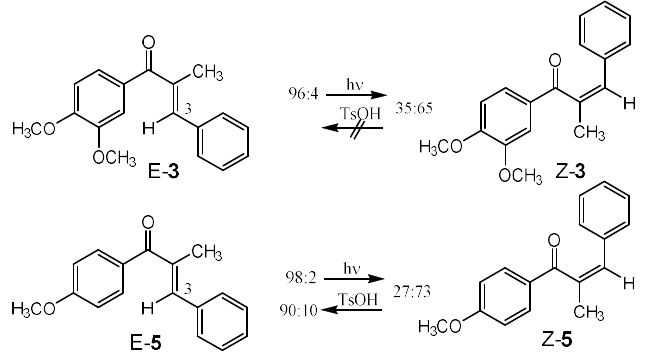
Figure 3. Long-time irradiation of the α-methyl chalcone 3 with 350 nm light in acetonitrile solutions, c = 10 −4 M. The PSS (E/Z = 35:65) is reached after approx. 6 h. No degradation (<2%) is detectable even after > 11 days of continuous irradiation. Table 1. Excitation wavelength, PSS, forward–backward photoisomerization quantum yields Φ.